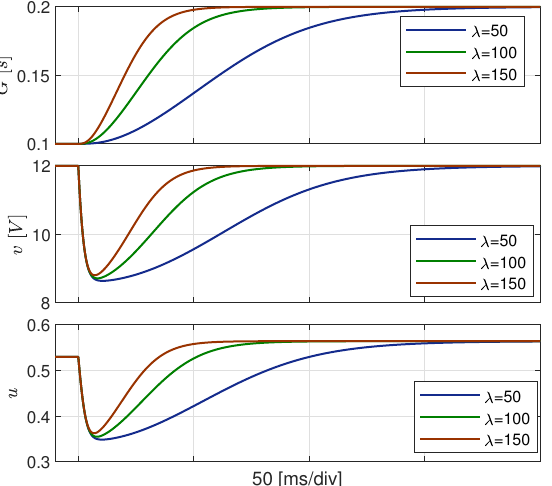
Figure 5. The response curves of the proposed controller in the presence of the change in G